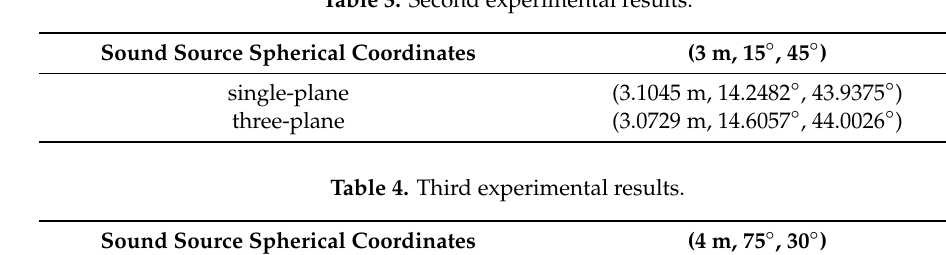
Table 3. Second experimental results.